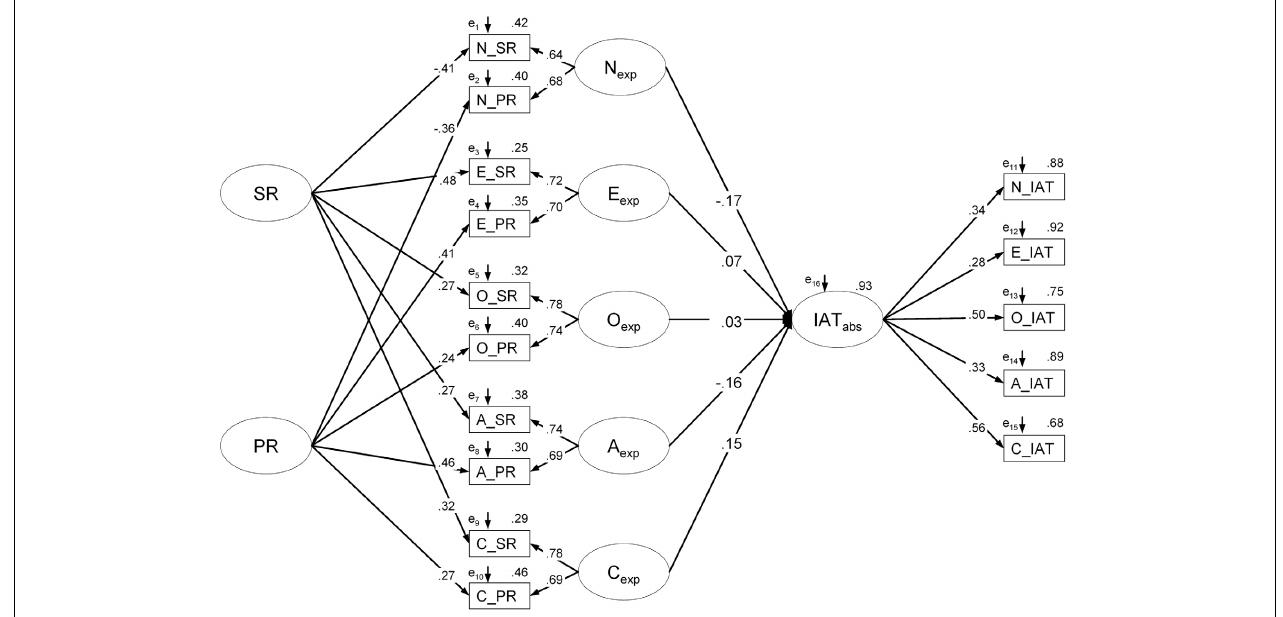
FIGURE 2 | Structural equation model with the IAT factor (IAT abs ) explaining variance in absolute IAT scores. Parameter estimates are fully standardized. Note that for reasons of readability, intercorrelations among the